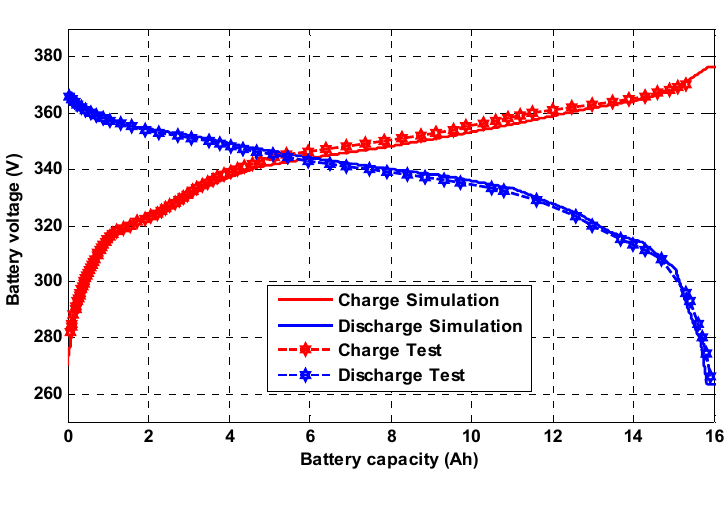
Figure 5. Battery model